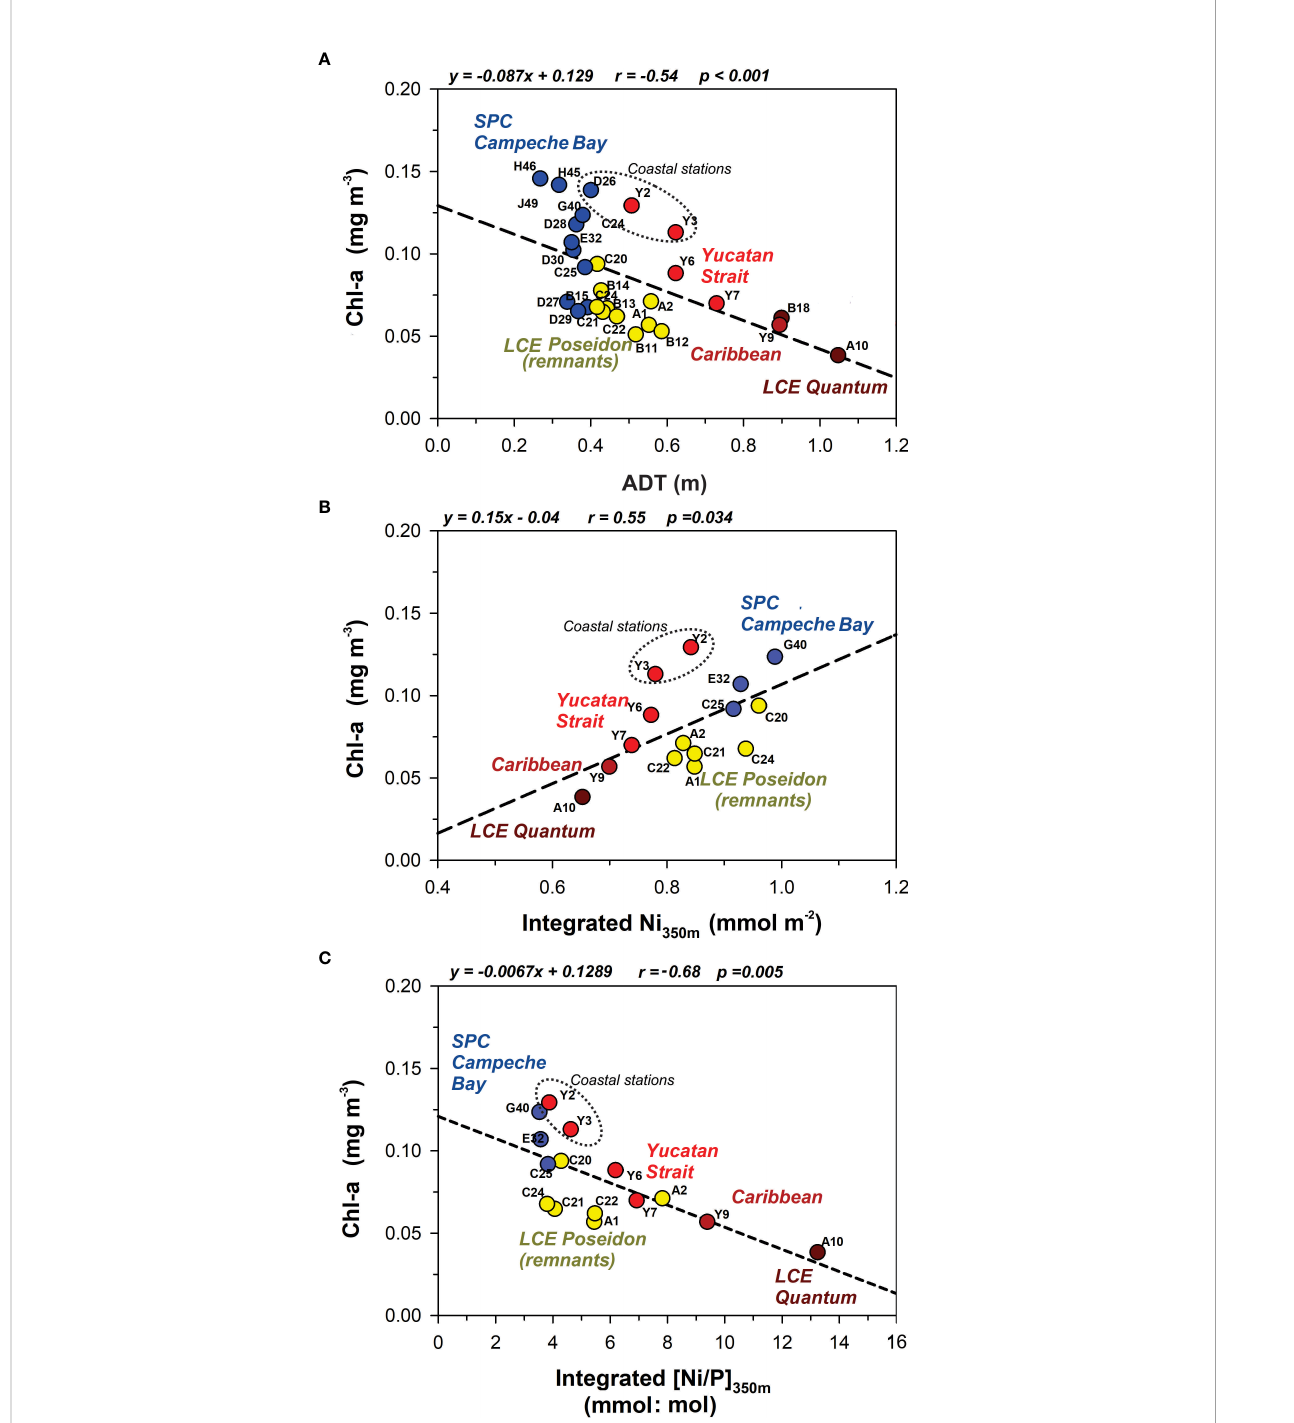
FIGURE 9 Relationship between satellite-derived chlorophyll a (Chl-a) and the variables of (A) absolute dynamic topography (ADT), (B) the integrated concentration of dissolved Ni in the fi rst 350 m of the water column and (C) the ratio of the integrated Ni and PO 4 concentrations for the upper 350 m of the water column ( ∫ Ni/ ∫ P). The Chl-a values were extracted from the 21-days composite image obtained for the XIXIMI-6 cruise (Figure 2C). The number of stations in panel (B) and (C) is < 22 due to limitations in the availability of satellite-derived Chl-a data (Figure 2C). The symbols in each panel are colored to identify the sampling stations within the three contrasting regions observed during the XIXIMI-6 cruise: semi-permanent cyclone (SPC) in Campeche Bay (blue); remnants of Loop Current eddy (LCE) Poseidon (yellow); and Loop Current (LC) + LCE Quantum (red). Dashed lines represent the linear fi t between each pair of